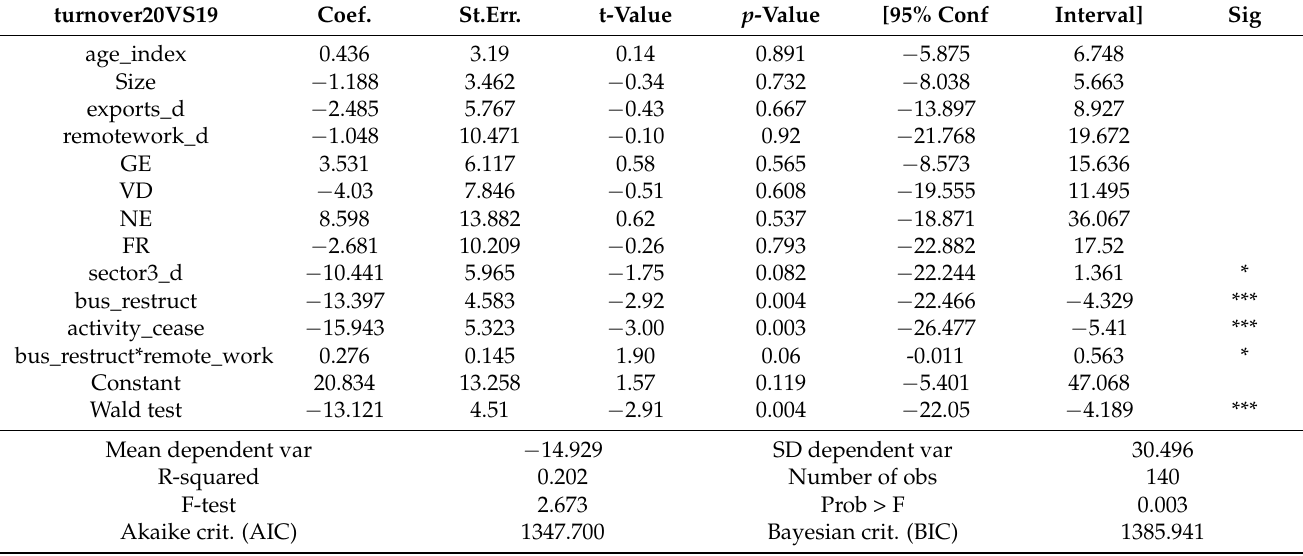
Table 10. Regression results—interacting business restructuring and remote work.